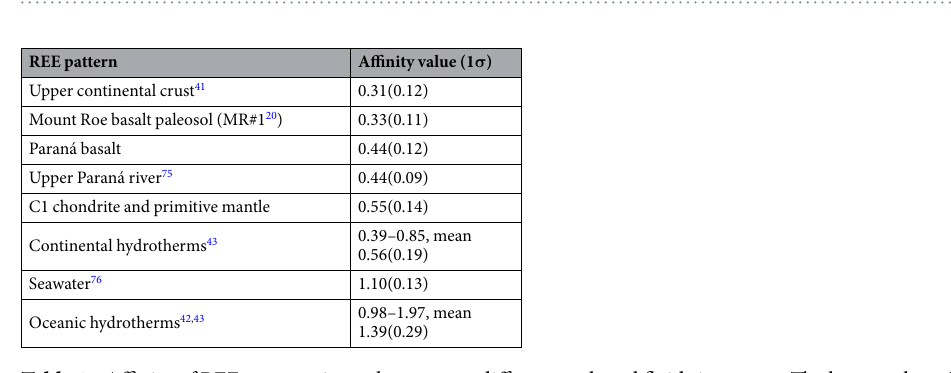
Table 1. Affinity of REE patterns in prokaryotes to different rock and fluid signatures. The lower value of the parameter corresponds to closer proximity between patterns (see